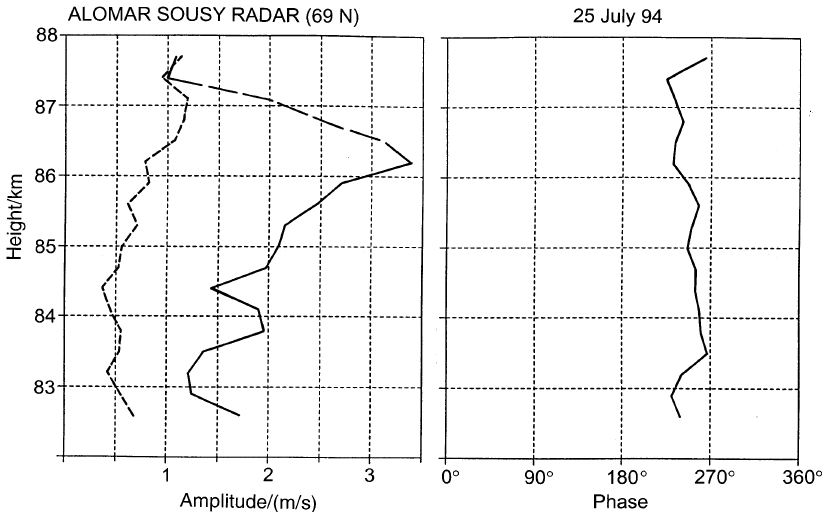
Fig. 4. Height profiles of amplitude and phase of the vertical velocity for the 9.6-min wave. The dashed curves represent the 90% significance levels